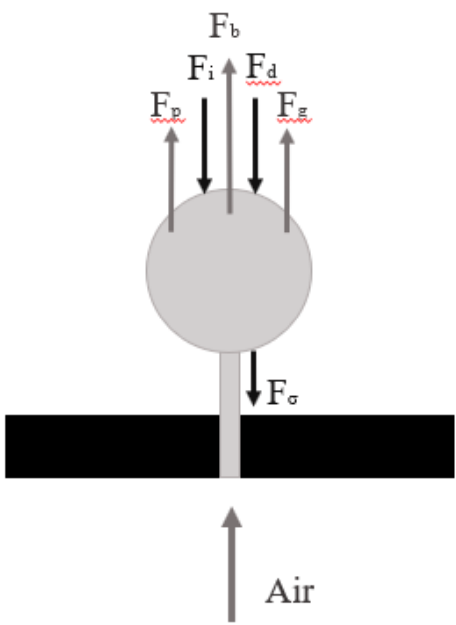
Figure 4. Forces acting on an under-formation bubble.